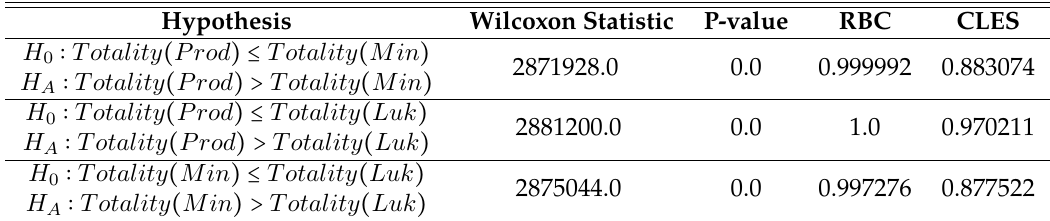
Table 6: Wilcoxon signed-rank test